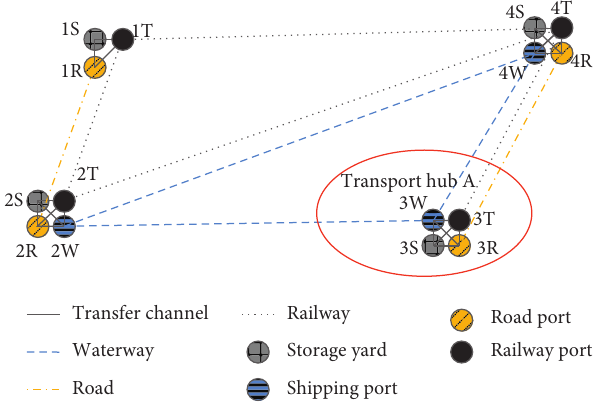
Figure 3: Intermodal transport